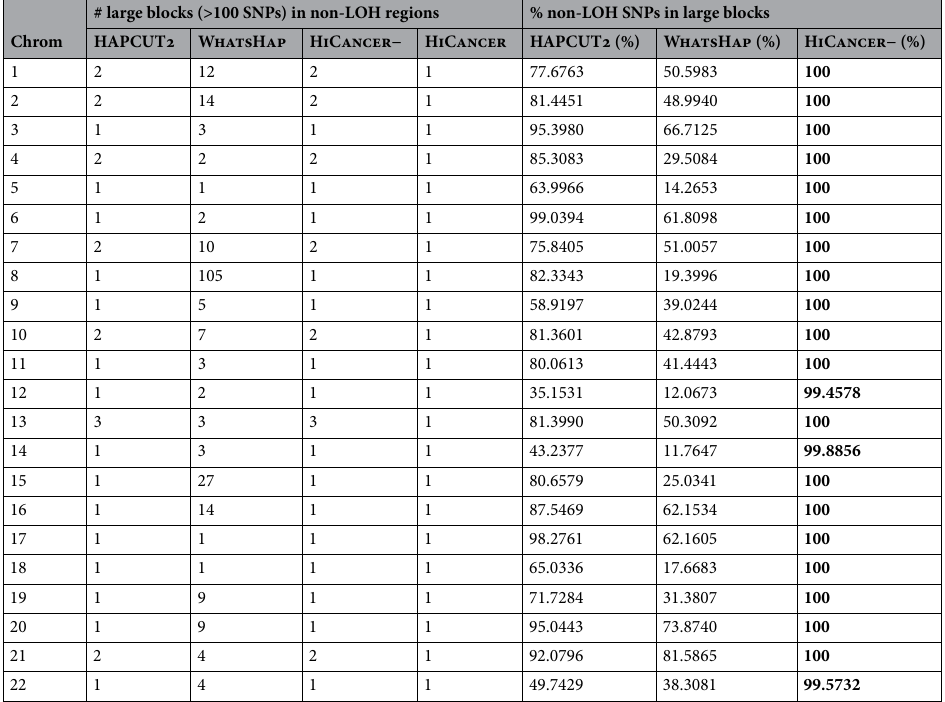
Table 3. Comparing the phasing performance of HiCancer with HAPCUT2 and WhatsHap on KBM7 genome. “Chrom” is the abbreviation of “Chromosome”; “HiCancer−” represents the output of HiCancer without doing the step of completing. Numbers in boldface highlight the best